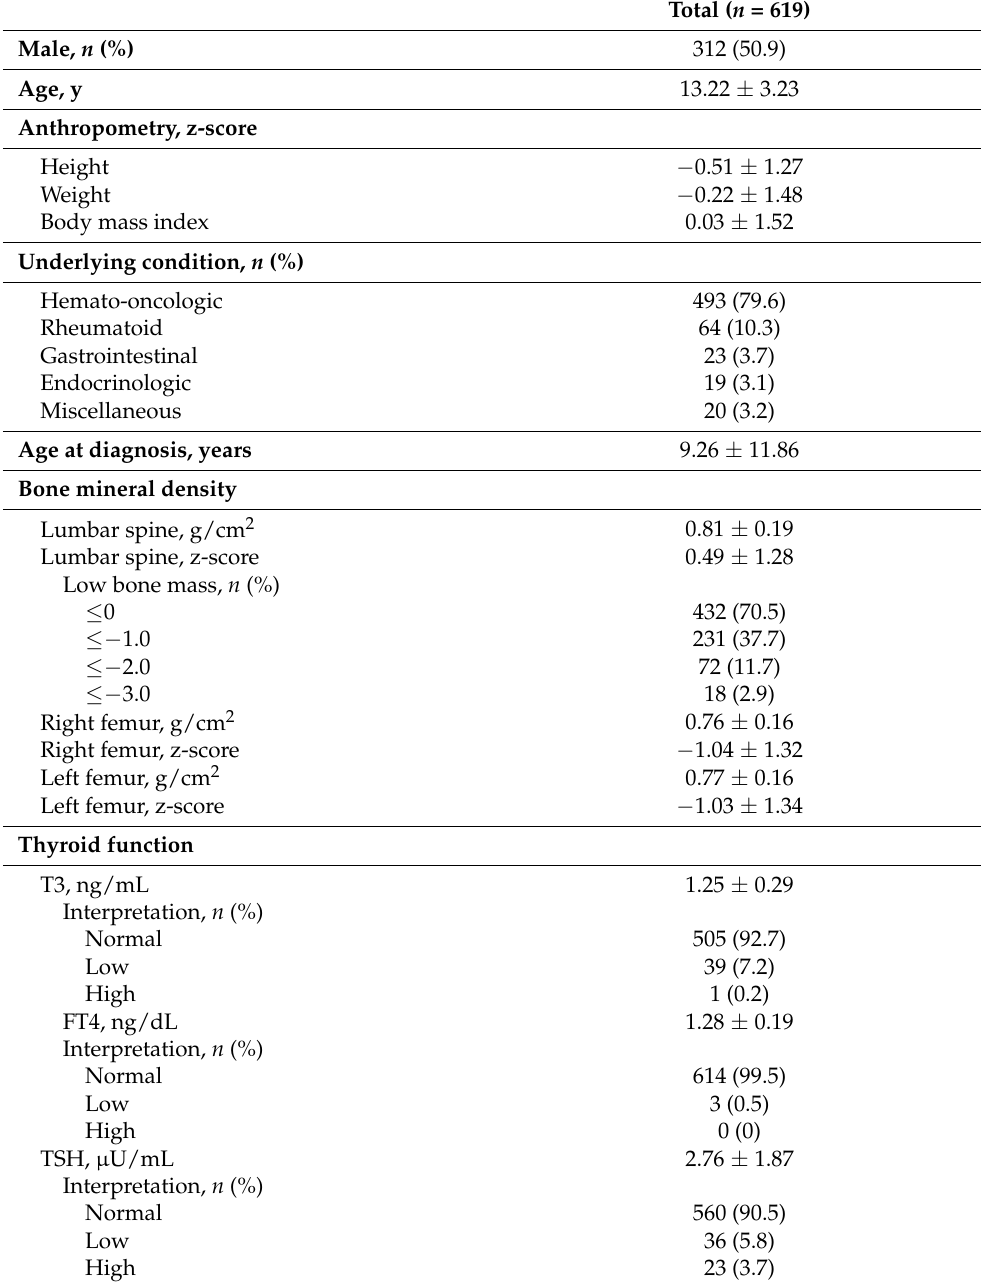
Table 1. Clinical description of the study